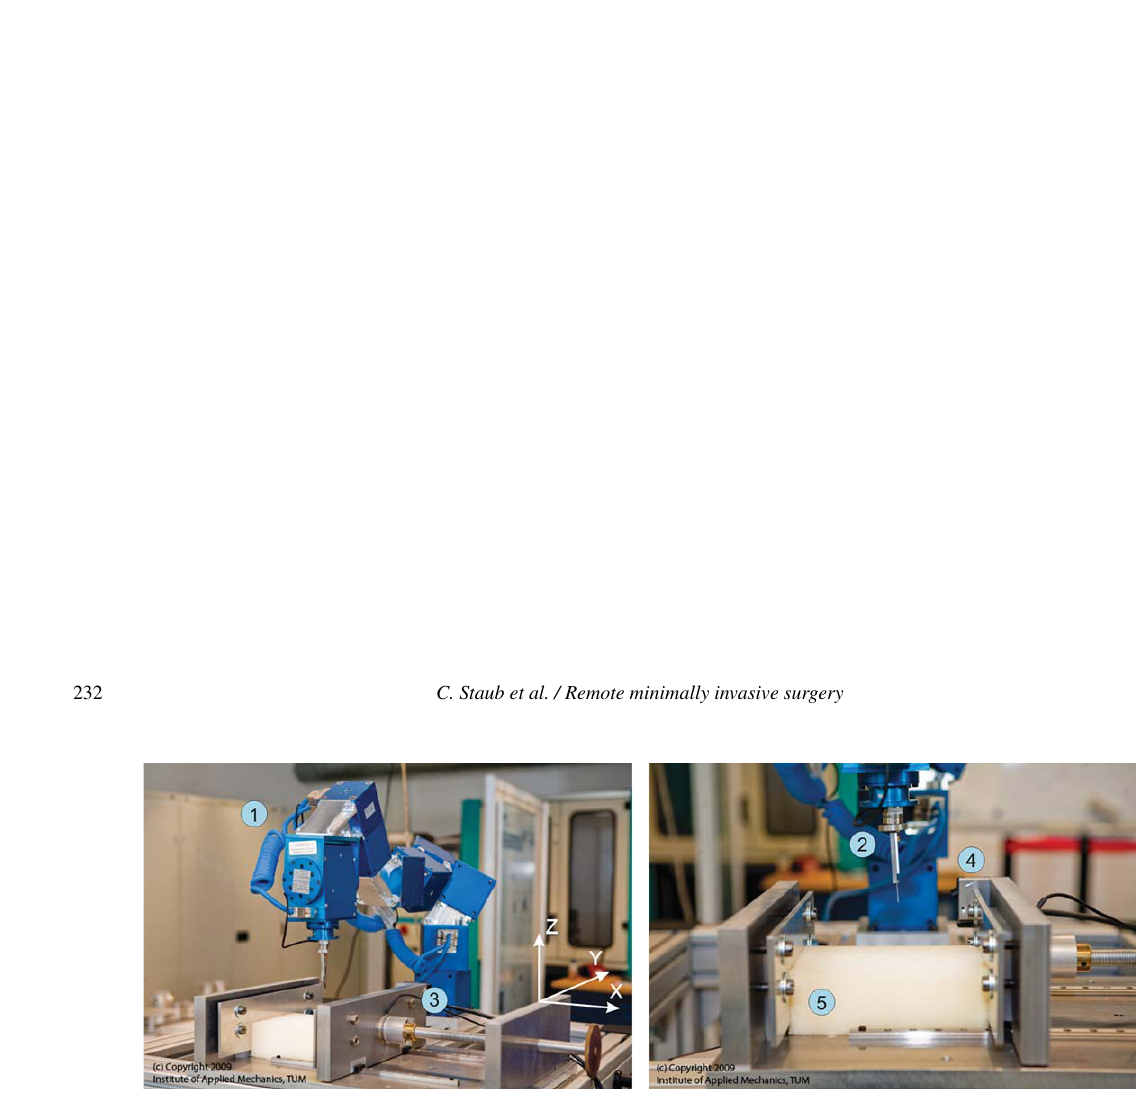
Fig. 8. Empirical modeling of the incision force: (1) 6DoF modular robot, (2) force sensor & scalpel: Measuring incision forces, (3) force-torque sensor: Measuring tension forces, (4) laser distance sensor: Measuring the total displacement, (5) test object. To efficiently represent constant